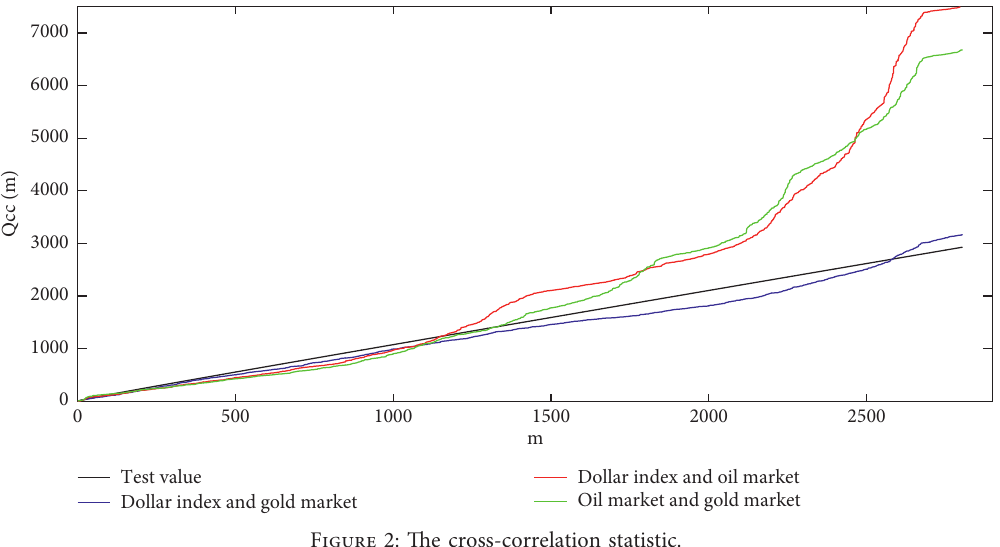
Figure 2: The cross-correlation statistic.